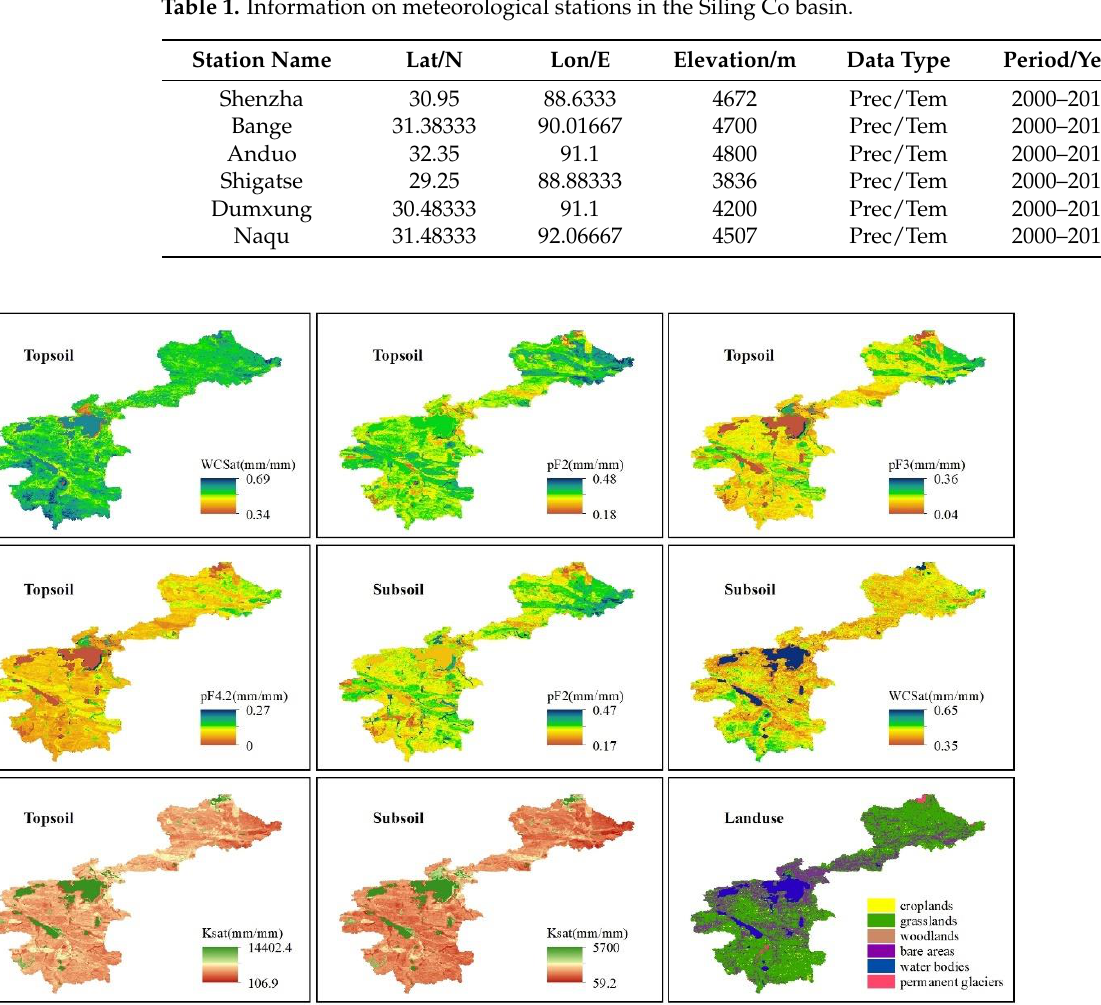
Figure 2. Spatial distribution of land use types and physical parameters in different soil layers.